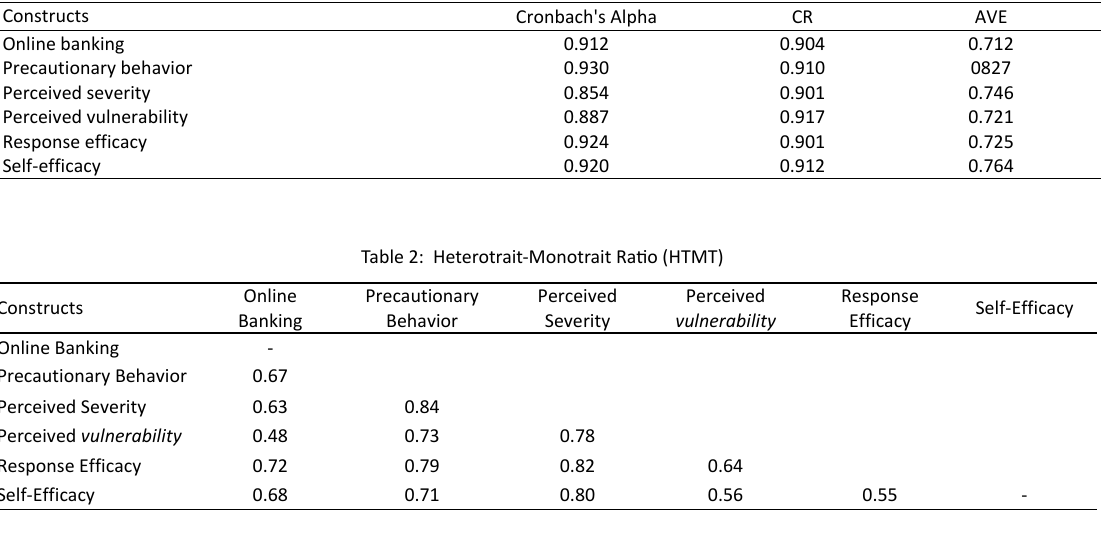
Table 1: Measurement Model